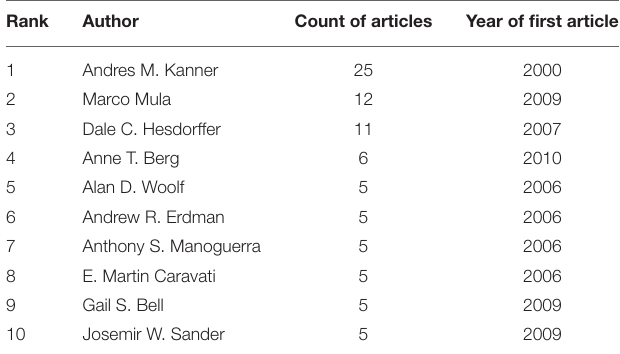
TABLE 2 | The top 10 authors of epilepsy with suicide.